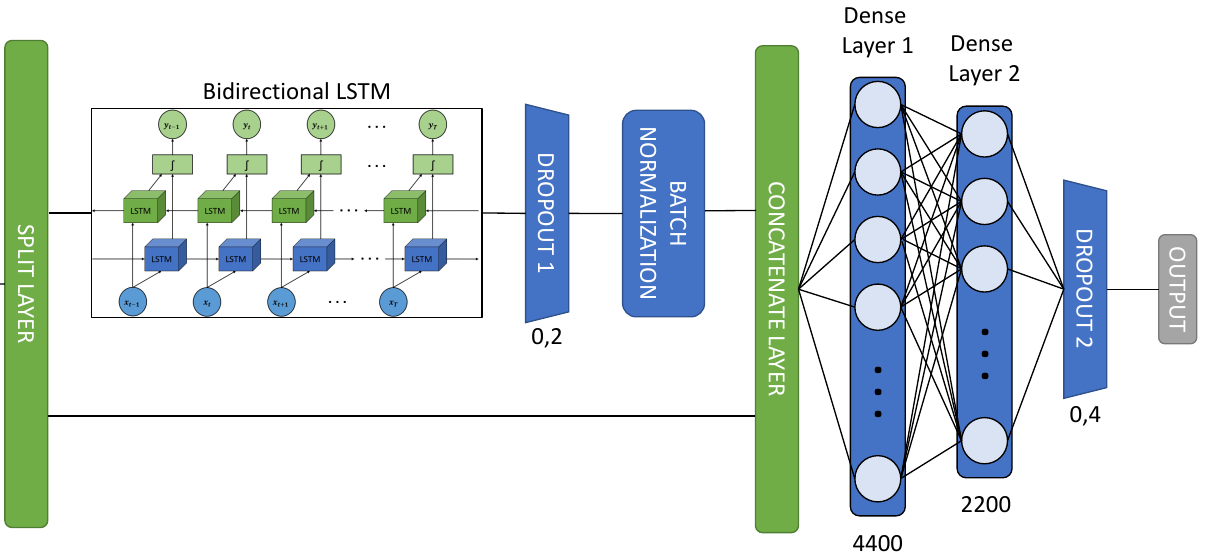
Figure 4. Neural network